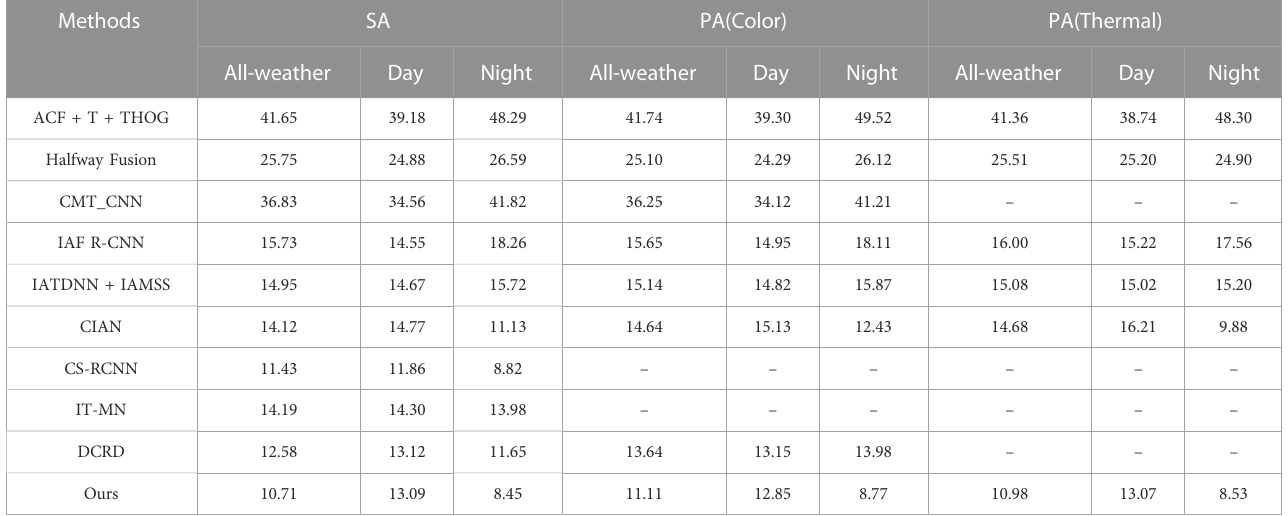
TABLE 2 MRs of different methods on KAIST datasets.